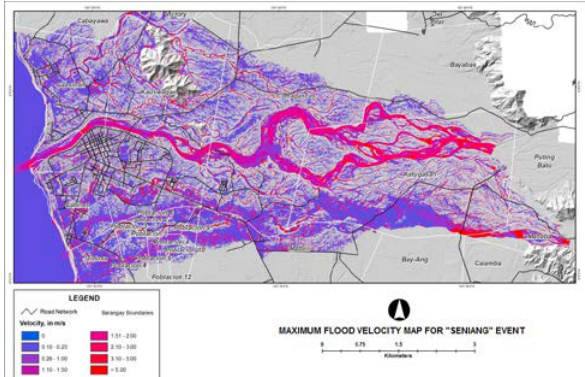
Figure 7. Map of maximum flood